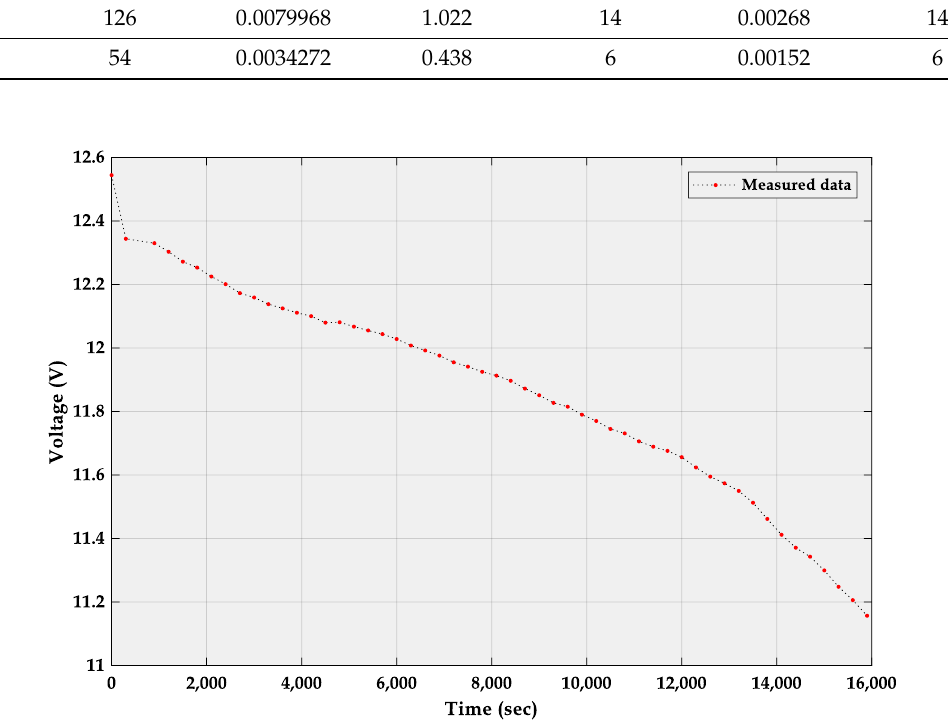
Table 6. Search space limits for Banner 120 Ah battery model.